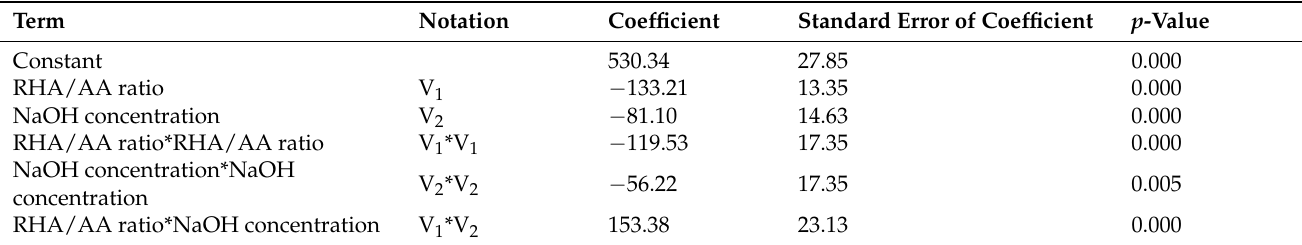
Table 6. Estimated effects and coefficient for RHA/AA ratio and NaOH concentration on the TT300.